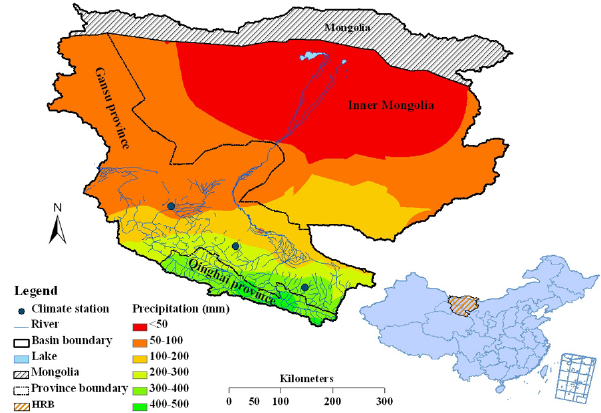
Fig. 1. Location of the Heihe River Basin (HRB) in